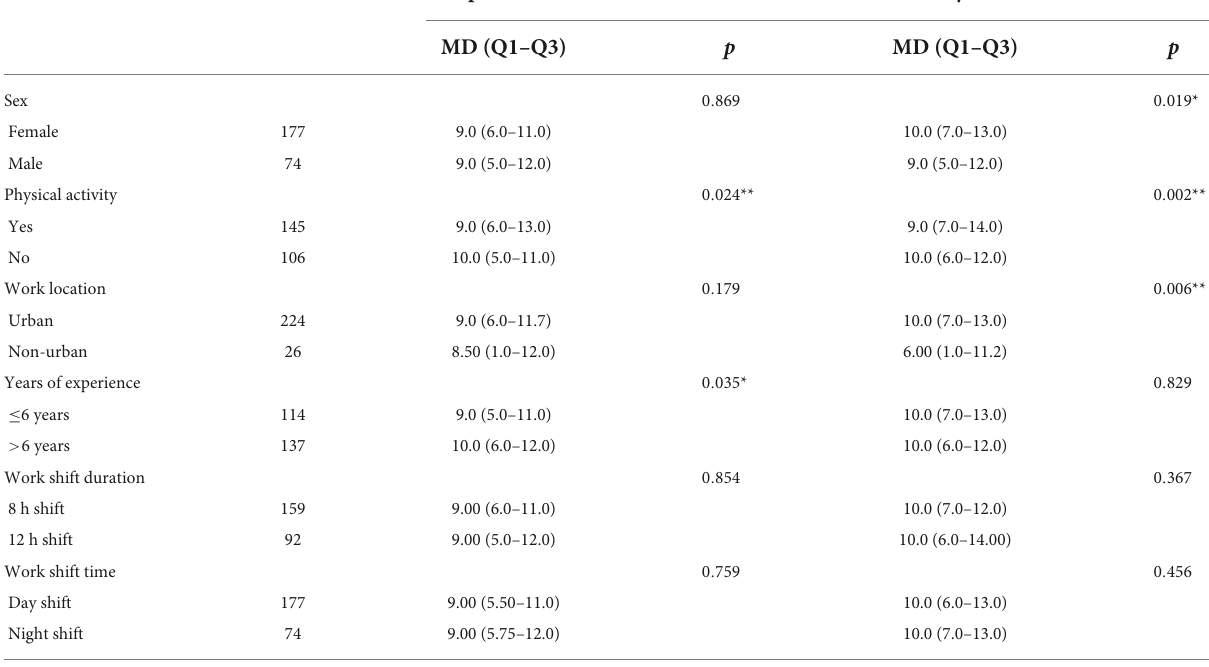
TABLE 3 Differences in factors contributing to anxiety and depression among ED nurses ( N = 251).